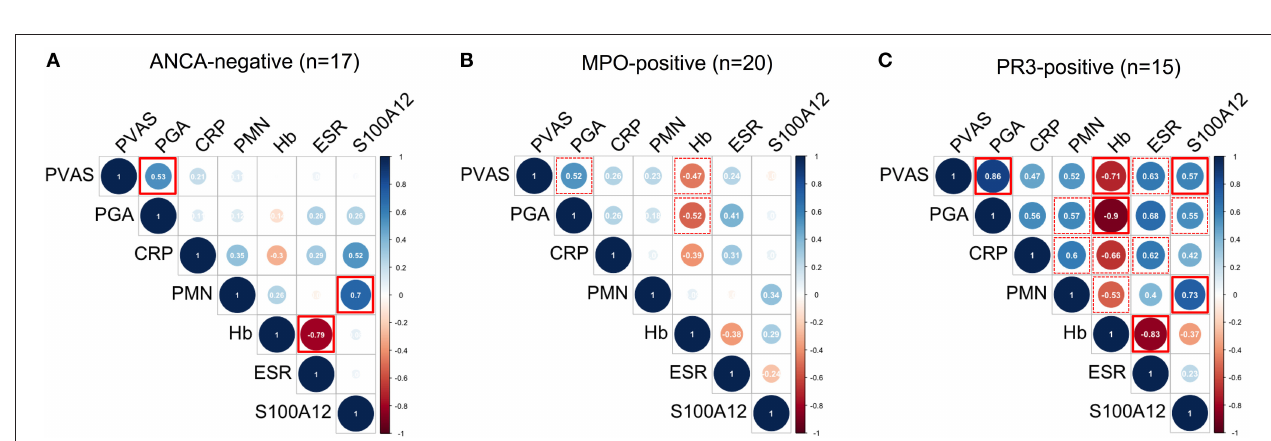
FIGURE 3 | Clinical disease activity scores and impact of corticosteroid treatment relative to ANCA-status. Clinical disease activity scores (A,C) PVAS (y-axis, range 0–63) and (B,D) PGA (y-axis; range 1–10) for children with small to medium sized vessel vasculitis that is associated (x-axis) with the absence (ANCA-neg) or presence of either MPO-ANCA (MPO + ) or PR3-ANCA (PR3 + ) is shown for all study visits (A,B) and at the time of diagnosis (C,D) . Data (A–D) were analyzed by Kruskal-Wallis test followed by Dunn’s multiple comparison test. Data are presented as box and whisker (10–90th percentile) with over-layed scattered dot plots ± SEM with means shown as horizontal lines. (E,F) Absolute polymorphonuclear leukocytes ( E,F ; right y-axis, PMN count × 10 9 /L), and related concentration of S100A12 ( E,F ; left y-axis, ng/ml) in patients with varying ANCA status (x-axis) receiving corticosteroid treatment over the course of disease (E) or specifically at the time of diagnosis (F) is shown.